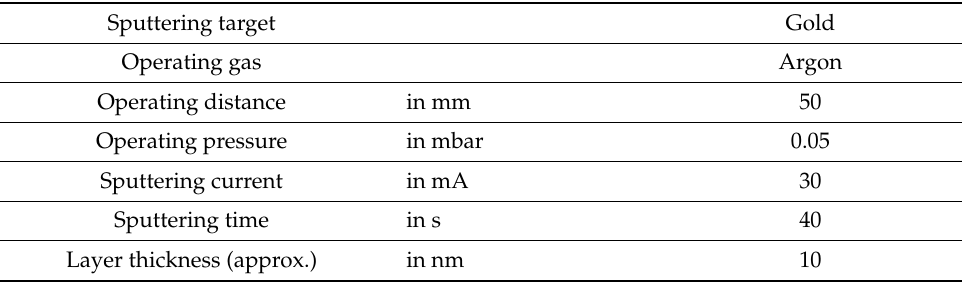
Table 2. Sputtering parameters of the contact pin coating process.